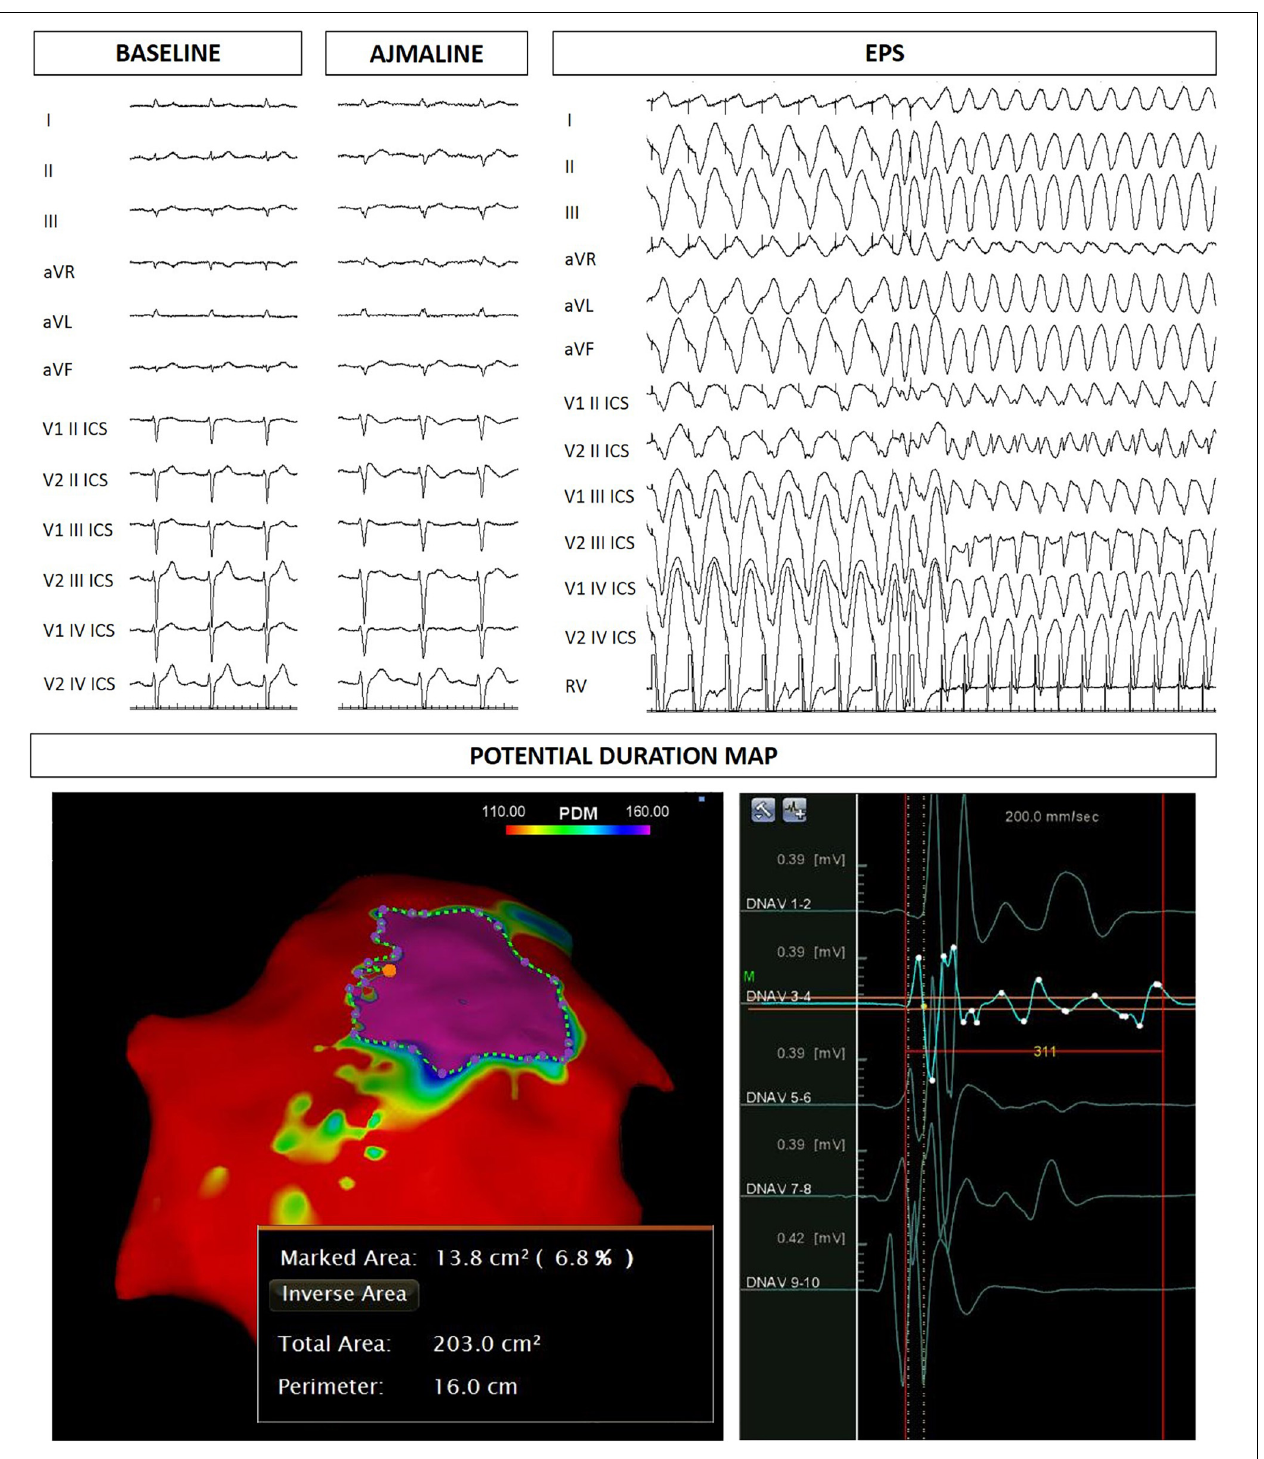
FIGURE 3 | Father of the proband: ECG at baseline, after ajmaline administration, VT/VF inducibility during EPS. Epicardial arrhythmogenic substrate.